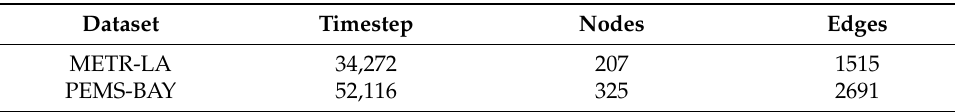
Table 1. Statistical properties of METR-LA and